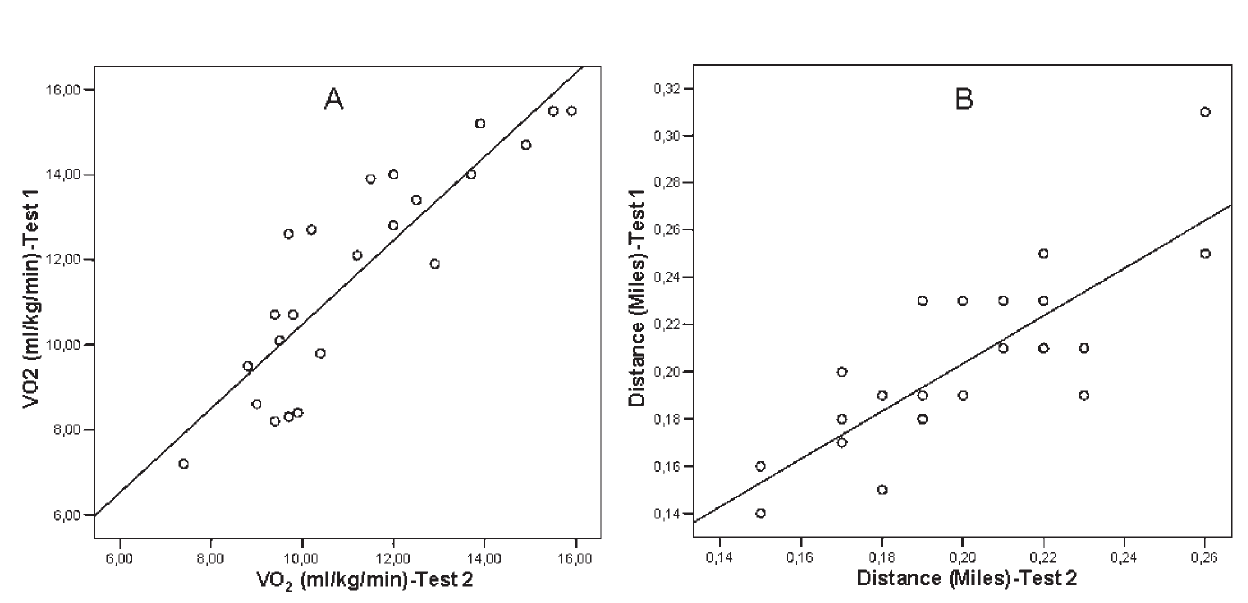
Figure 1 - Regression linear between test-1 and test-2 for VO2 (A) and Distance